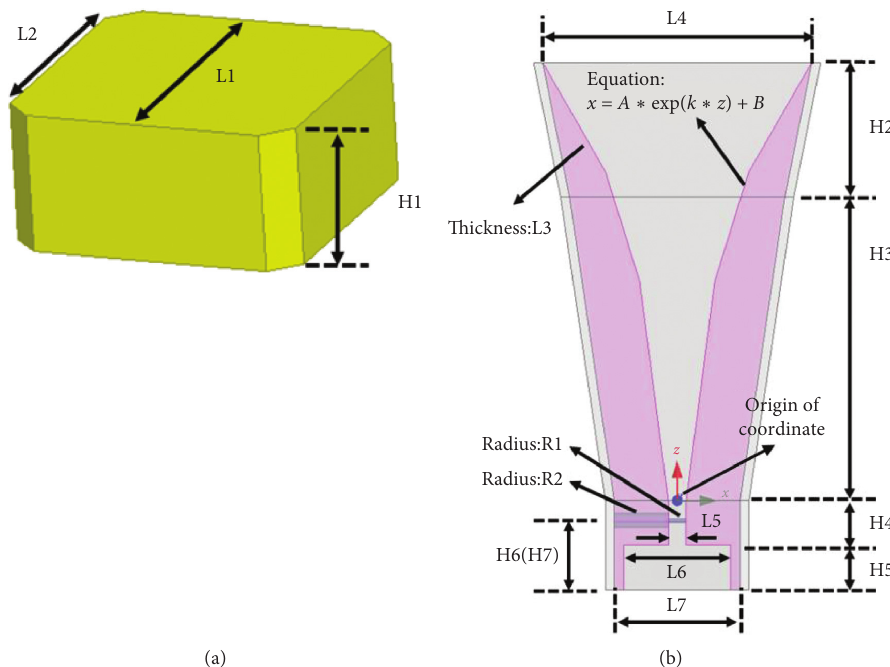
Figure 2: (a)-(b) The structure of the lens-loaded FRHA. L1 � 32mm, L2 � 26mm, L3 � 2.4mm, L4 � 30mm, L5 � 2mm, L6 � 12mm, L7 � 14mm, H1 � 18mm, H2 � 15 mm, H3 � 34 mm, H4 � 5 mm, H5 � 5mm, H6 � 7mm, H8 � 7.8mm, R1 � 0.25mm, R2 � 0.85mm, k � 50m − 1 , A � 1.322mm, and B �− 0.322mm.